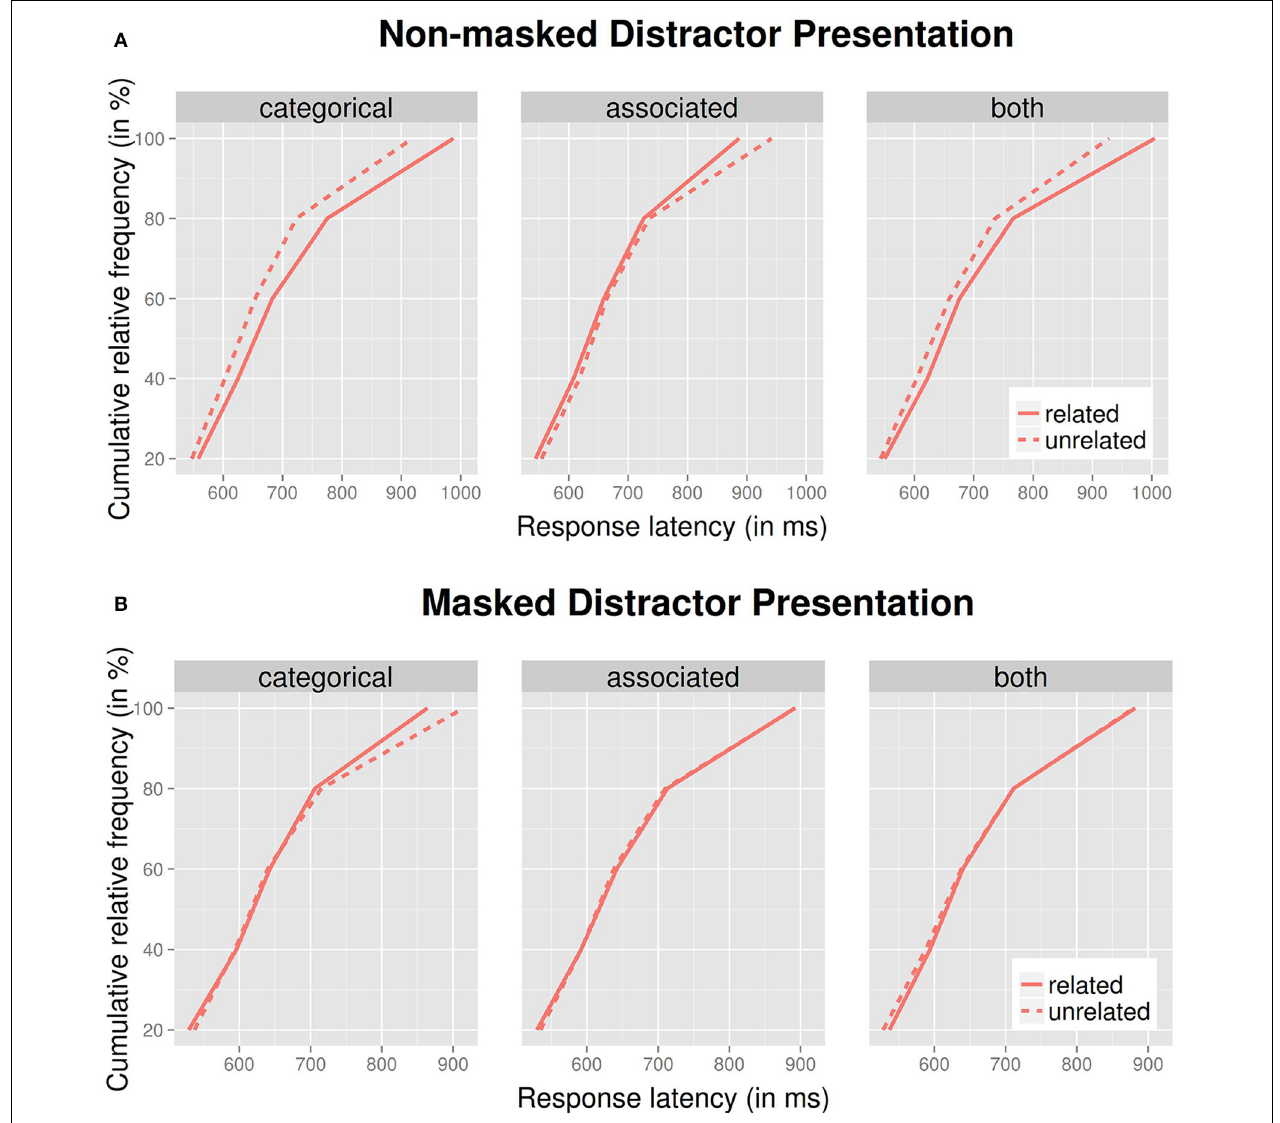
FIGURE 2 | Vincentized cumulative distribution curves for non-masked and masked distractor presentations (A and B, respectively), by relatedness type (categorical, associated, both) and relatedness (related vs.